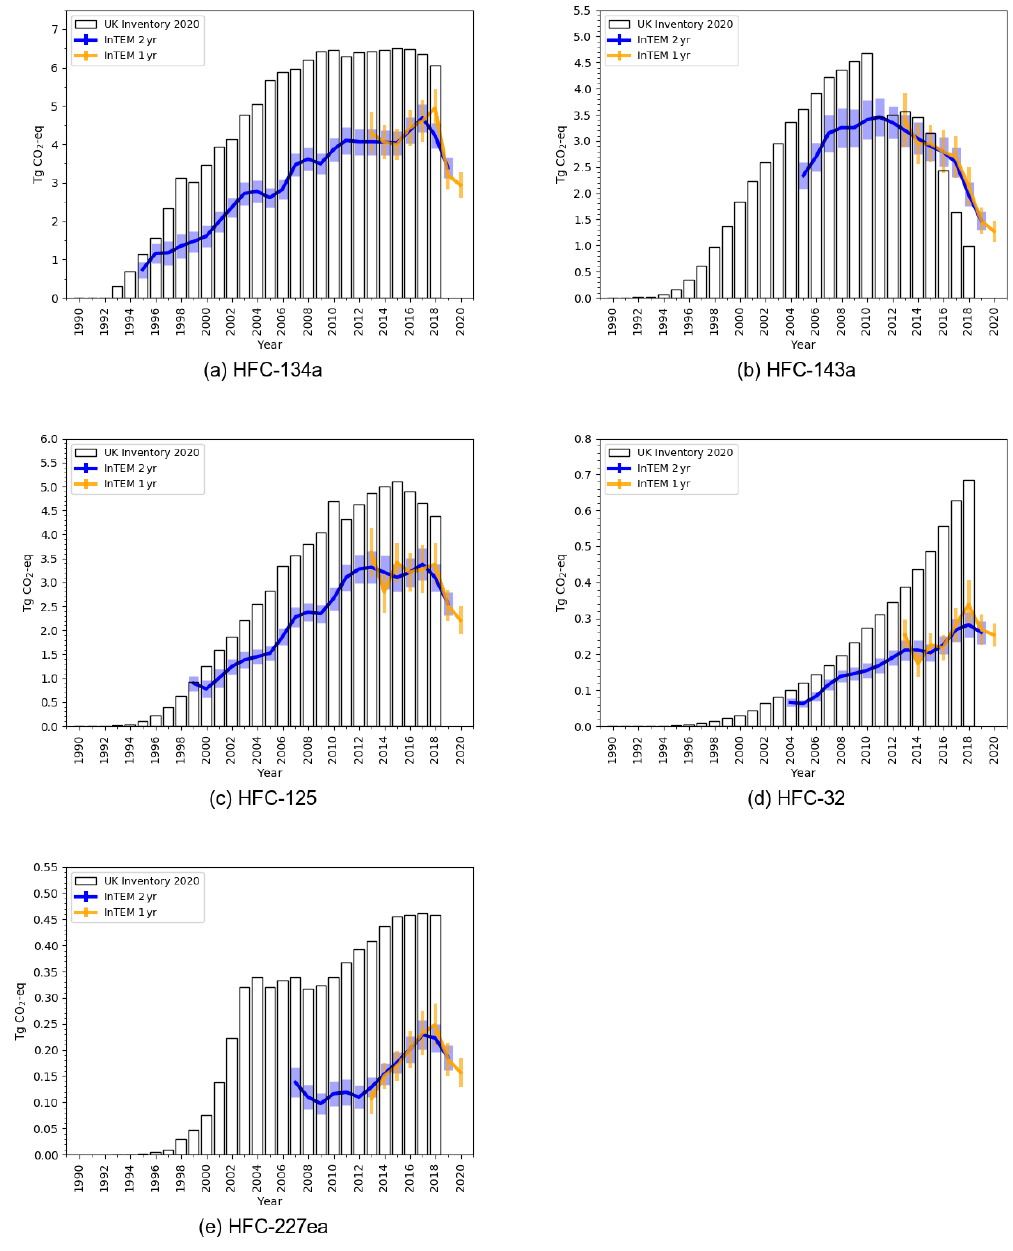
Figure 5. Annual UK emission estimates (TgCO 2 -eq) from the UK 2020 inventory (black), InTEM annualized 2-year inversion (blue) and InTEM 1-year inversion (orange) (a) HFC-134a, (b) HFC-143a, (c) HFC-125, (d) HFC-32 and (e) HFC-227ea. The uncertainty bars represent 1 σ